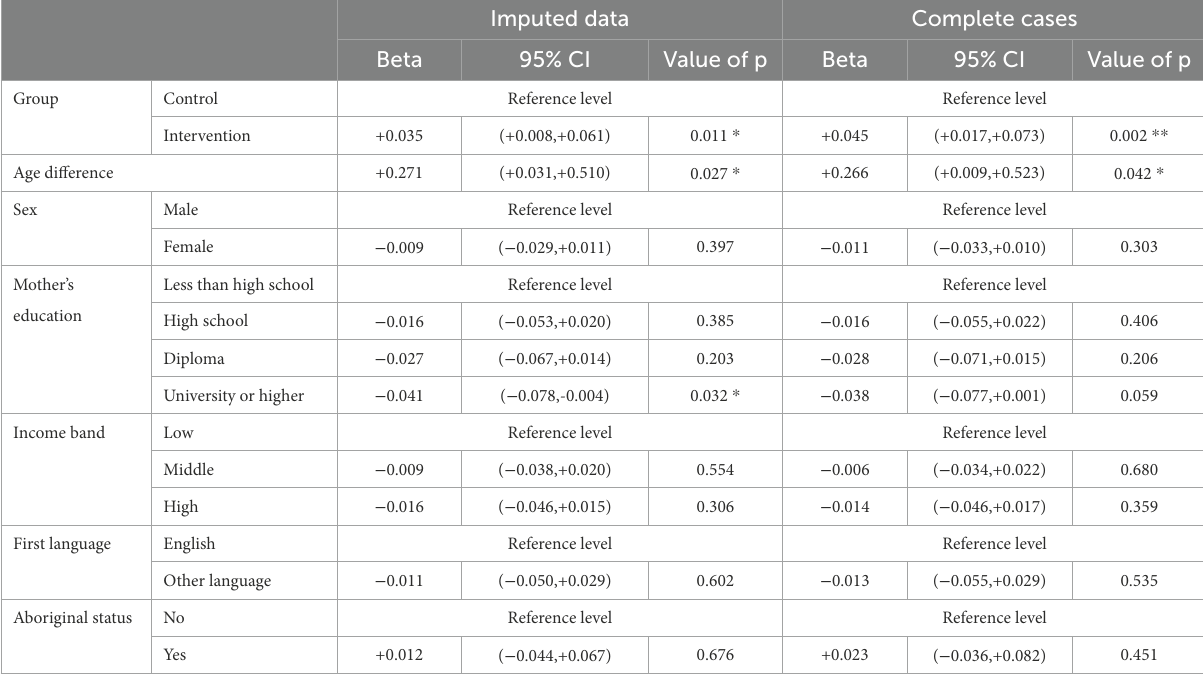
TABLE 8 Results of regression model of difference between pre-and post-intervention Preschool Early Numeracy Scale scores; models fitted to multiply imputed data ( N = 1,129) and to complete cases only ( N = 958).